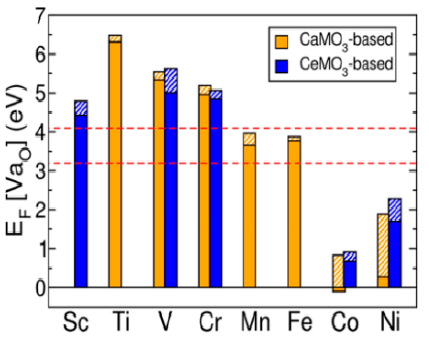
Figure 6. Oxygen vacancy formation energy of Ca 0.5 Ce 0.5 MO 3 perovskites derived from CaMO 3 (orange bars) and CeMO 3 (blue bars) oxides. Red dashed lines show the target scope for solar thermochemical hydrogen production (3.2~4.1 eV). Reprinted with permission from Ref. [77], copyright 2020, American Chemical Society.